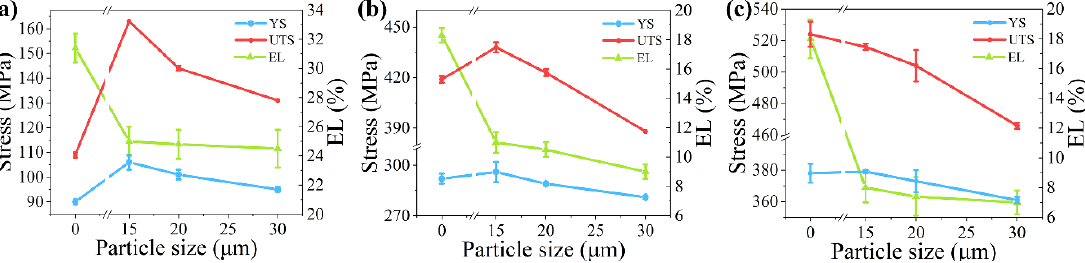
Figure 2. The yield strength (YS), ultimate strength (UTS), and elongation (EL) of the composites with ( a ) matrix L, ( b ) matrix M, and ( c ) matrix H. The mechanical properties of 0 µ m particle represents the mechanical properties of the